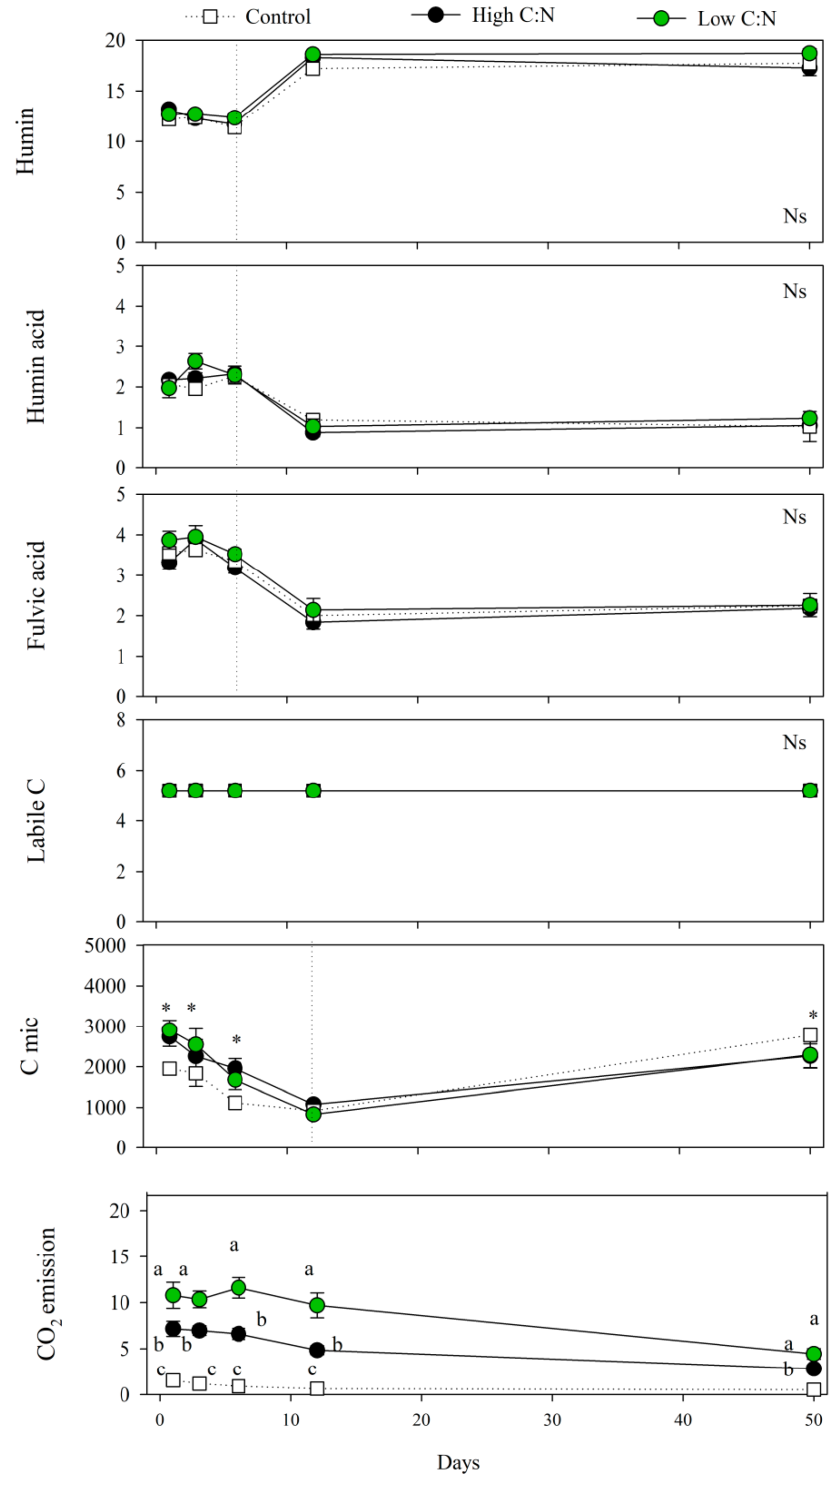
Figure 1. Daily humin (g kg −1 ), fulvic acid (g kg −1 ), humic acid (g kg −1 ), labile C (g kg −1 ), microbial biomass carbon (C mic, μg g −1 ha −1 ), and CO 2 emission (g CO 2 m −2 h −1 ) during 50 days of incubation. Ns: no difference; * difference between residue additions (high and low C:N) and control. In CO 2 emissions, the mean of the residues and the control were compared by the LSD test ( p < 0.05). The variables were monitored on the 1st, 3rd, 6th, 12th, and 50th day of